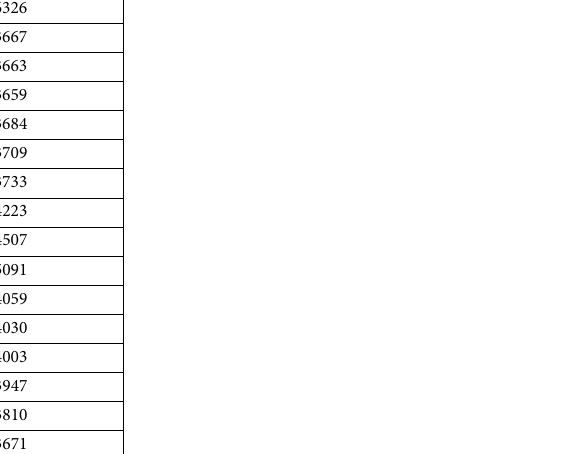
Table 4. LNN comparison with ref. 43